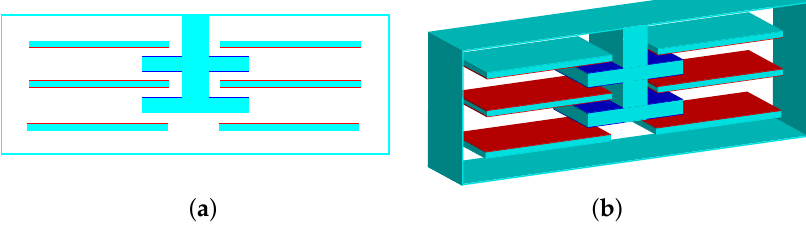
Figure 12. The surface-to-surface contact: ( a ) the front view (2D). ( b ) the three-dimensional map